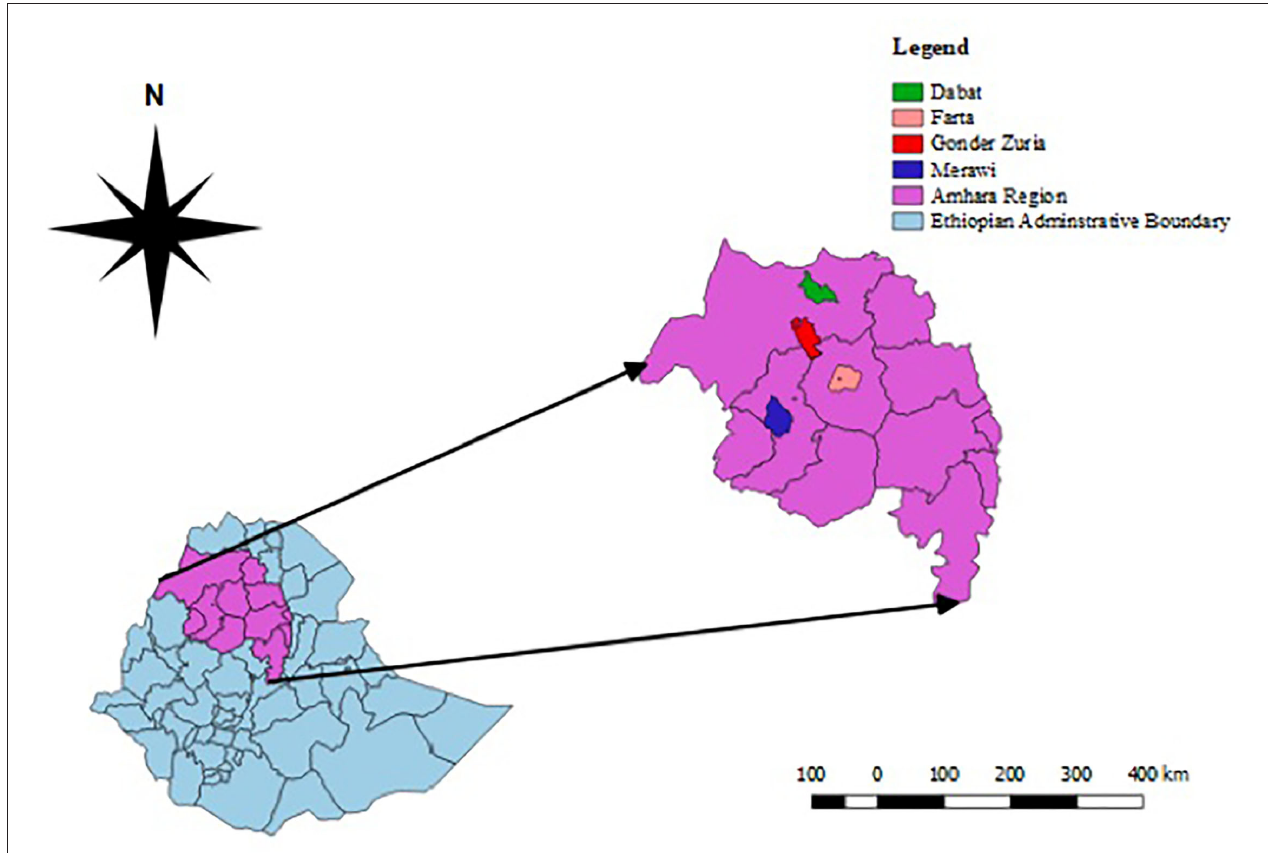
FIGURE 1 | Map depicting the different districts of the study area in the West Amhara sub-region. The map was created by QGIS version 2.18.1 Las Palmas.